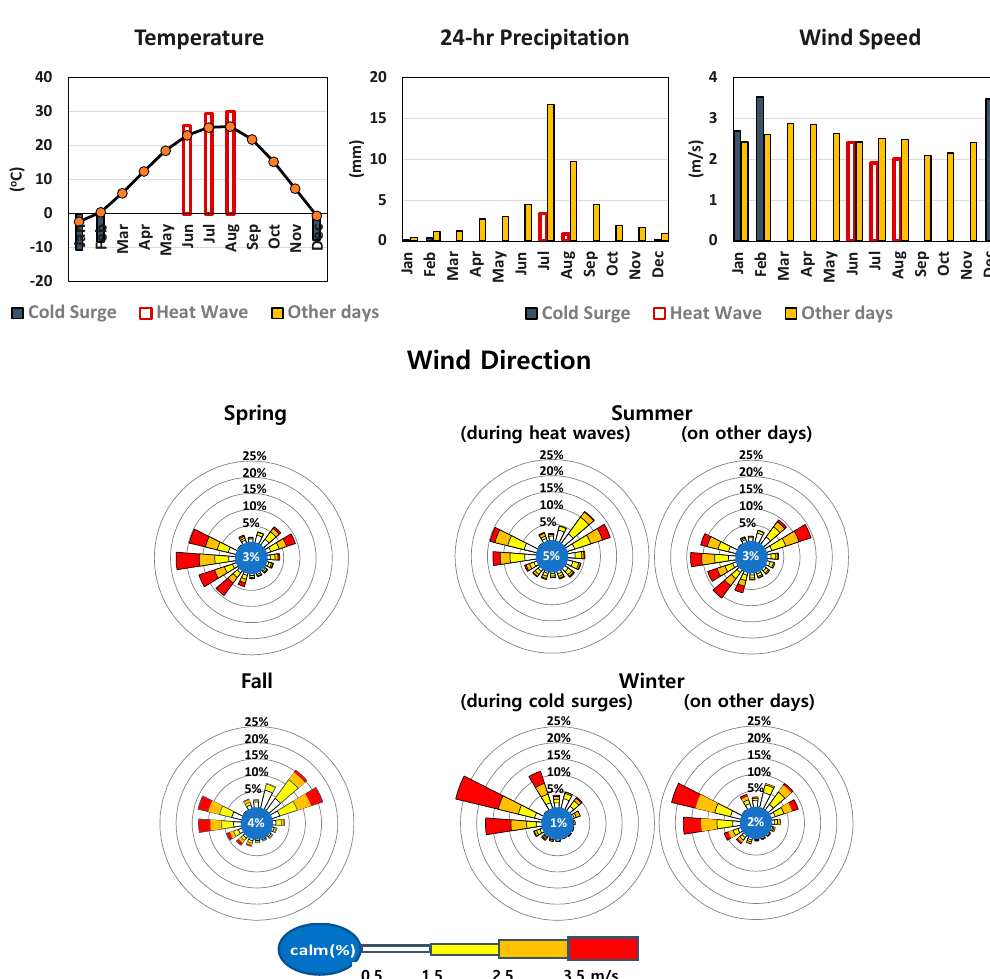
Figure 2. Monthly average temperature, precipitation, wind speed, and seasonal average wind direction.